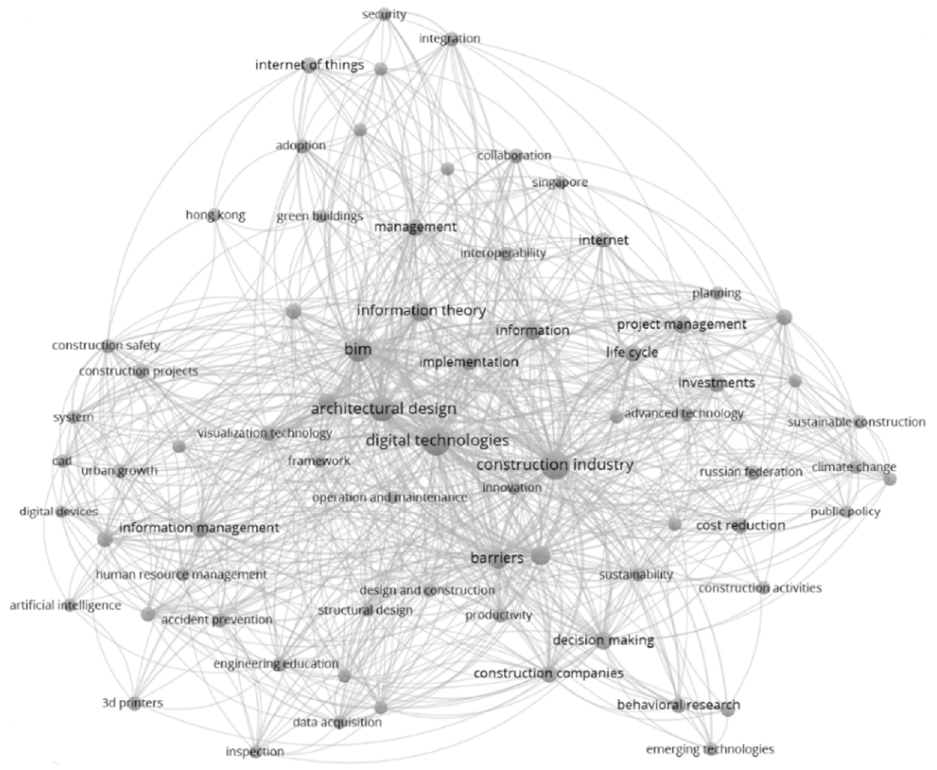
Figure 2. Scientometric keyword visualization of the combined literature database (CLD) via VOSviewer.